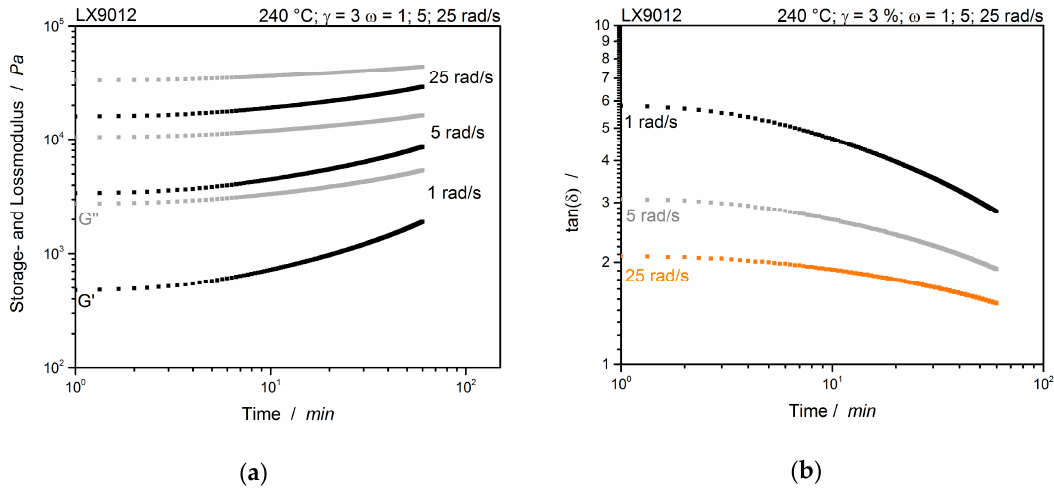
Figure 6. Multiwave test of unmodified LX9012 as reference measured simultaneous with different frequencies. (a) Storage- and loss modulus and (b) tan( δ ). Measured at 240 °C.